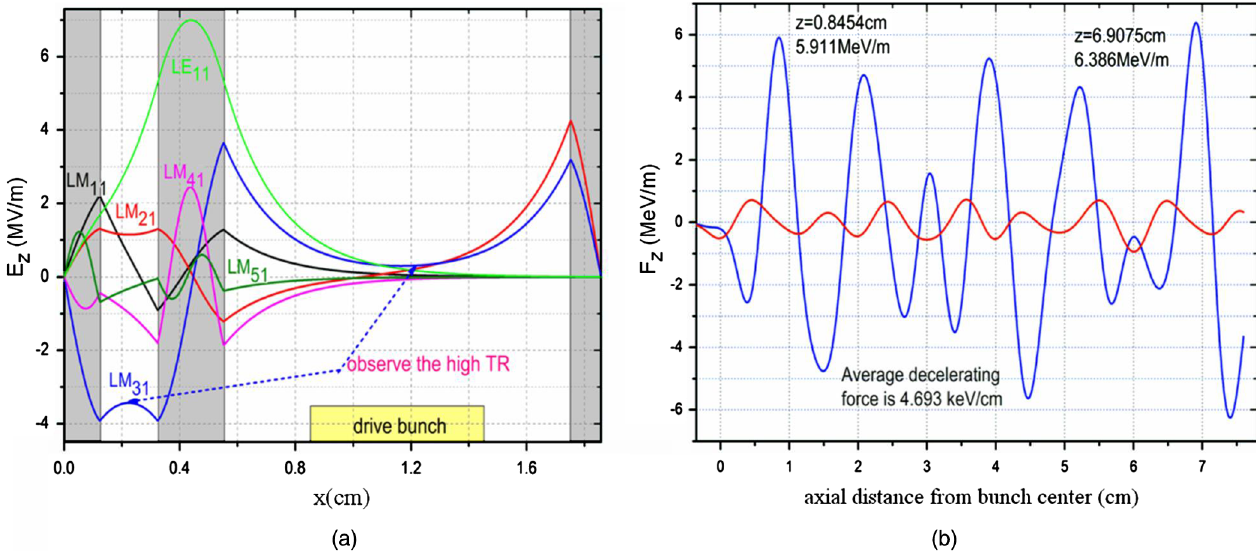
FIG. 4. (a) Some of the modes which may be excited by a drive bunch. The resulting wakefield is a composite F z force on the test bunch as shown in (b). These curves are given for a 50 nC drive bunch. The curve with the large magnitude in the narrow channel is the accelerating force acting on the test bunch, and the curve with the smaller magnitude in the wide channel is the decelerating force acting on the drive bunch.